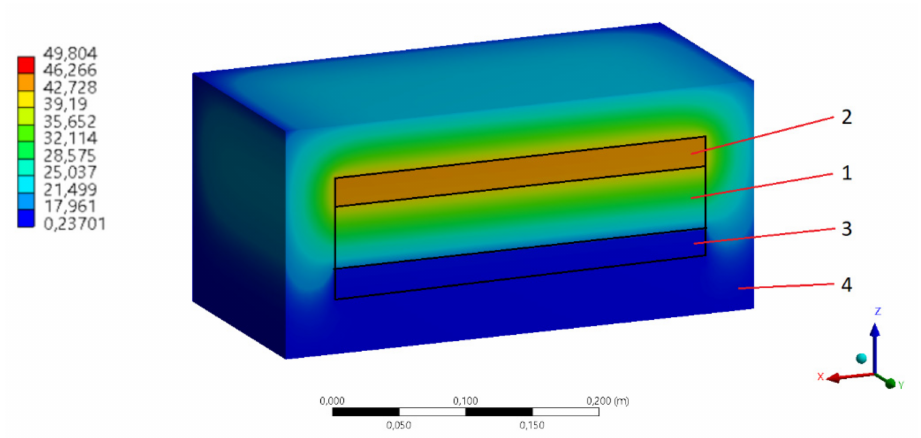
Figure 8. Temperature distribution in the calorimeter FE model (cross section): 1—sample, 2—heating and high temperature measurement plates, 3—cooling and low temperature measurement plates, 4—thermal and moisture